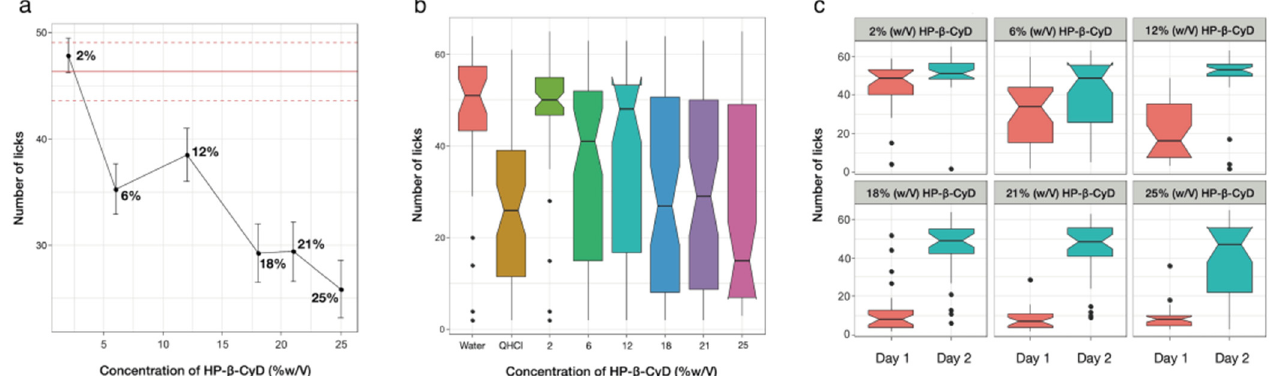
Figure 4. ( a ) Average number of licks (±SEM) as a function of concentration (% w/v ) for HP- β -CyD, with the red lines representing the number of licks for water +/ − 95% confidence interval; ( b ) boxplots representing the number of licks recorded for both testing days as a function of HP- β -CyD concentration (% w/v ) − QHCl = quinine hydrochloride control at IC50; ( c ) boxplots representing the differences in number of licks recorded as a function of HP- β -CyD concentration (% w/v ) between testing day 1 (red) and testing day 2 (blue).